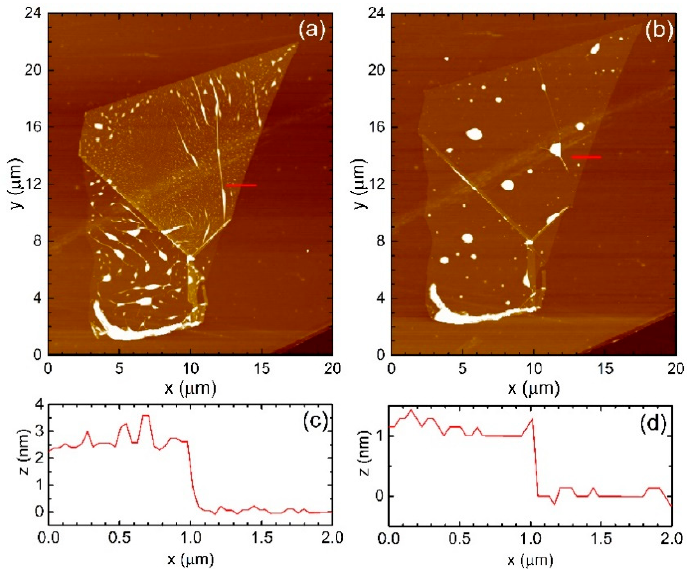
Figure 1. AFM images of the WSe 2 flake on the top of the annealed hexagonal boron nitride (hBN) layer: ( a ) before and ( b ) after the annealing for 20 min at 180 °C in air. Line profiles of the red lines shown in the AFM images ( c ) before and ( d ) after annealing.